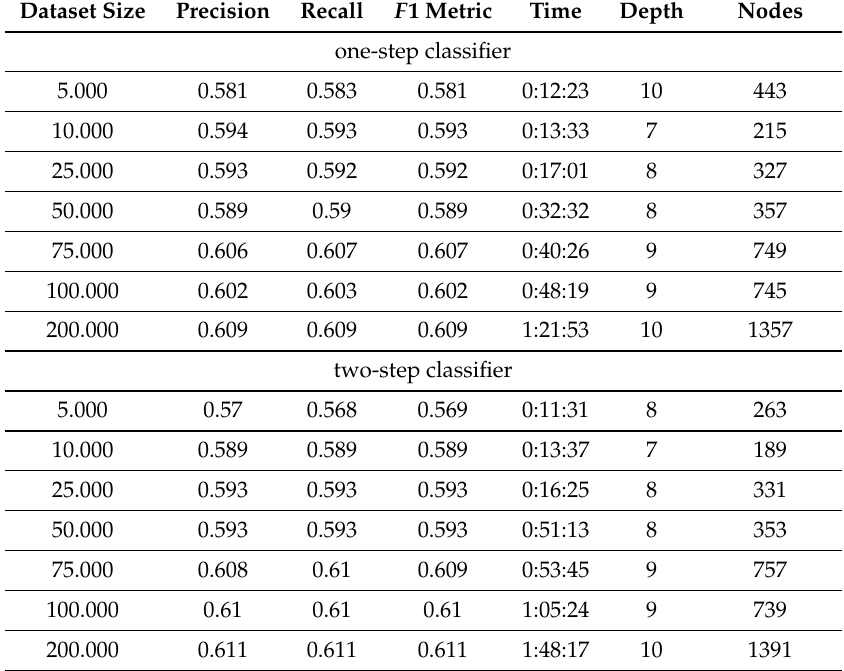
Table 6. Decision tree.